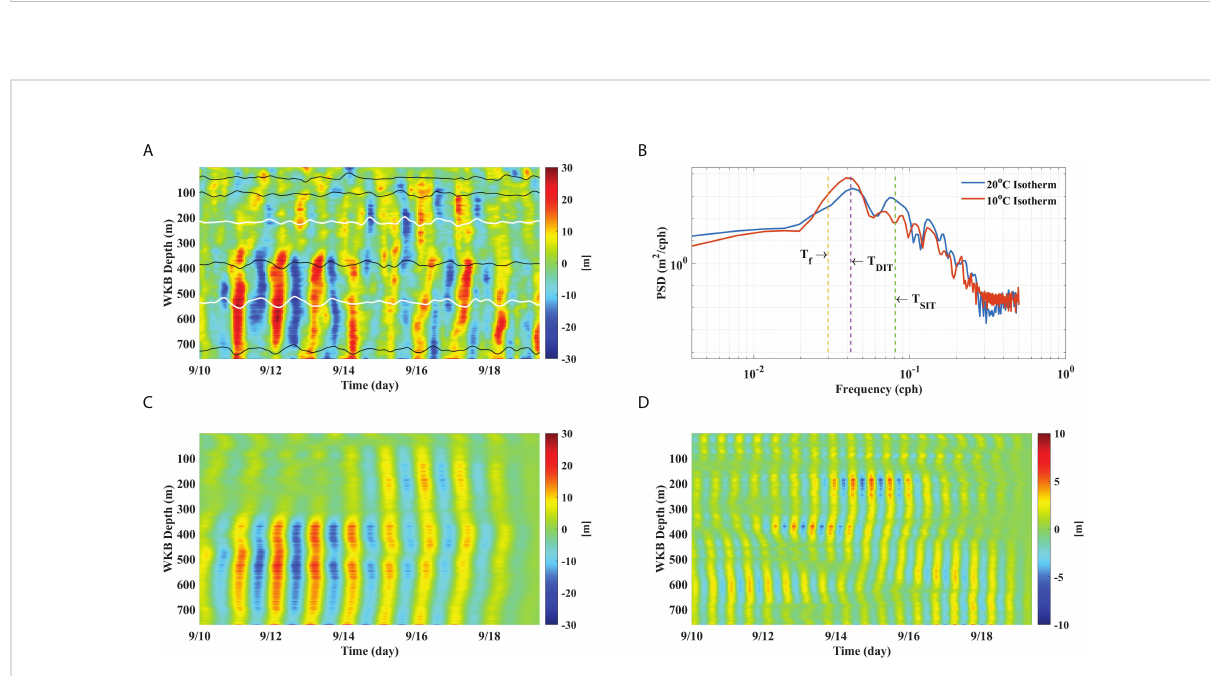
FIGURE 5 (A) The depth – time map of WKB-scaled isothermal displacements is depicted with isotherms corresponding to 29°C, 25°C, 20°C, 15°C, 10°C, and 6°C, where two white lines indicate 20°C and 10°C. (B) The power spectrums of vertical displacements of two isotherms correspond to 20° C (the upper layer) and 10°C (the lower layer), respectively. DIT dominates in the lower layer, whereas SIT is more pronounced in the upper layer rather than in the lower layer. (C) Diurnally band-passed isothermal displacements are depicted, showing a phase discrepancy between the upper and lower layers at the eddy center and gradually becoming in-phase away from the center. (D) Semi-diurnally band-passed vertical displacements show a complex pattern in magnitudes and